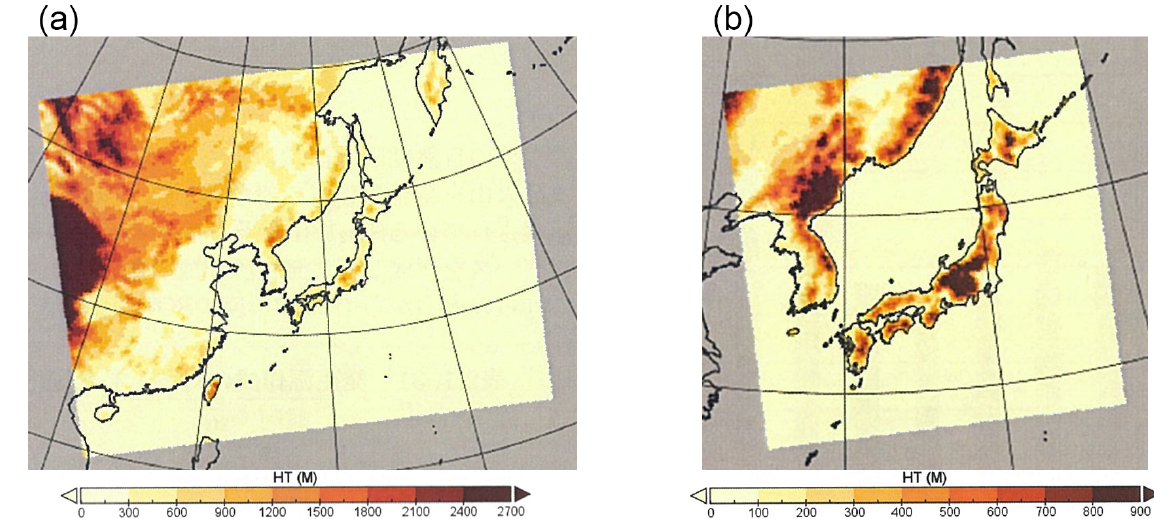
Figure 1. Ranges of (a) Domain 1 and (b) Domain 2 of the WRF–CMAQ models in this study. Color bars denote altitude.